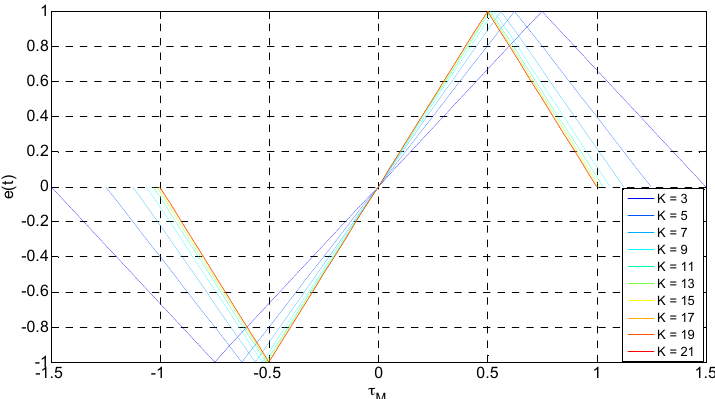
Figure 4. The structure diagram of the transmitter in the ASF correction system.